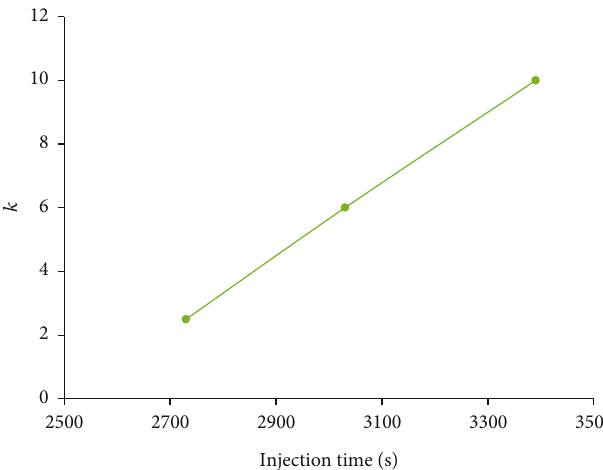
Figure 9: Flow channel coe ffi cient k vs. time.